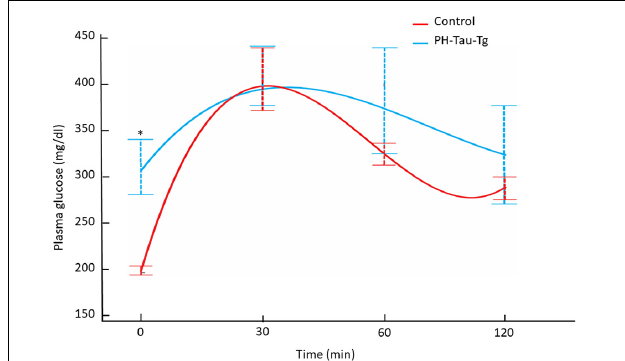
FIGURE 6 | Intraperitoneal glucose tolerance test on overnight fasted control mice ( n = 7) and PH-Tau-Tg mice ( n = 9). Values are expressed as means ± SEM obtained from three experiments. ∗ p < 0.05 when compared with control